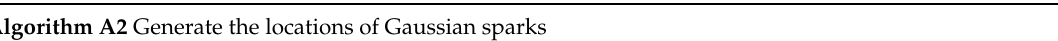
Algorithm A2 Generate the locations of Gaussian sparks For j = 1 to ˆ Q /* ˆ Q is the number of Gaussian